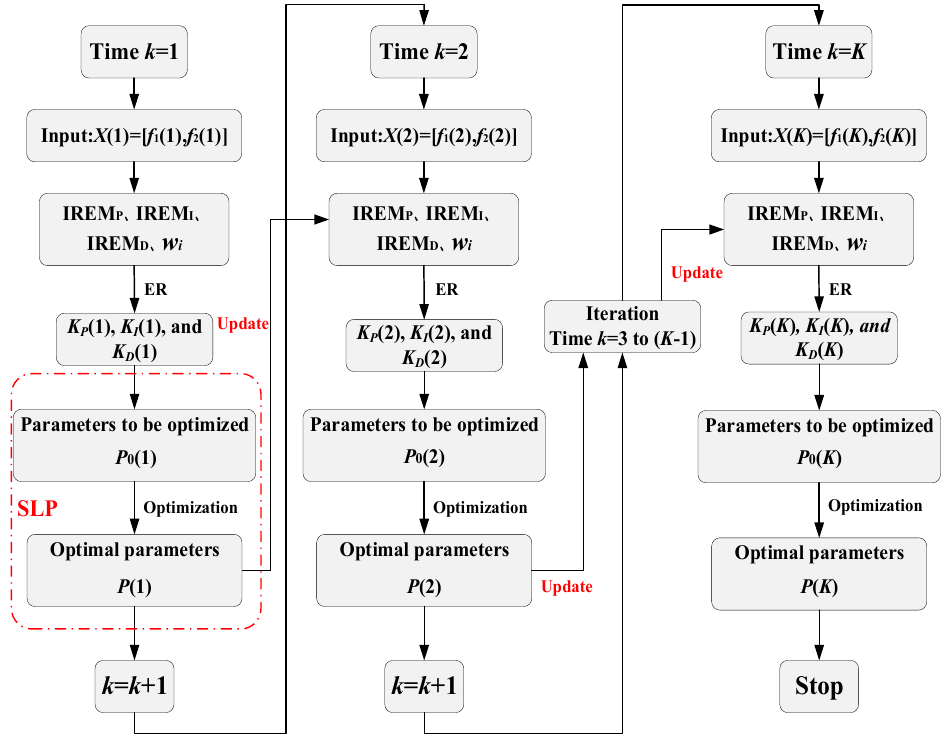
Figure 6. Iterative parameter updating for the ER ‐ PID controller.